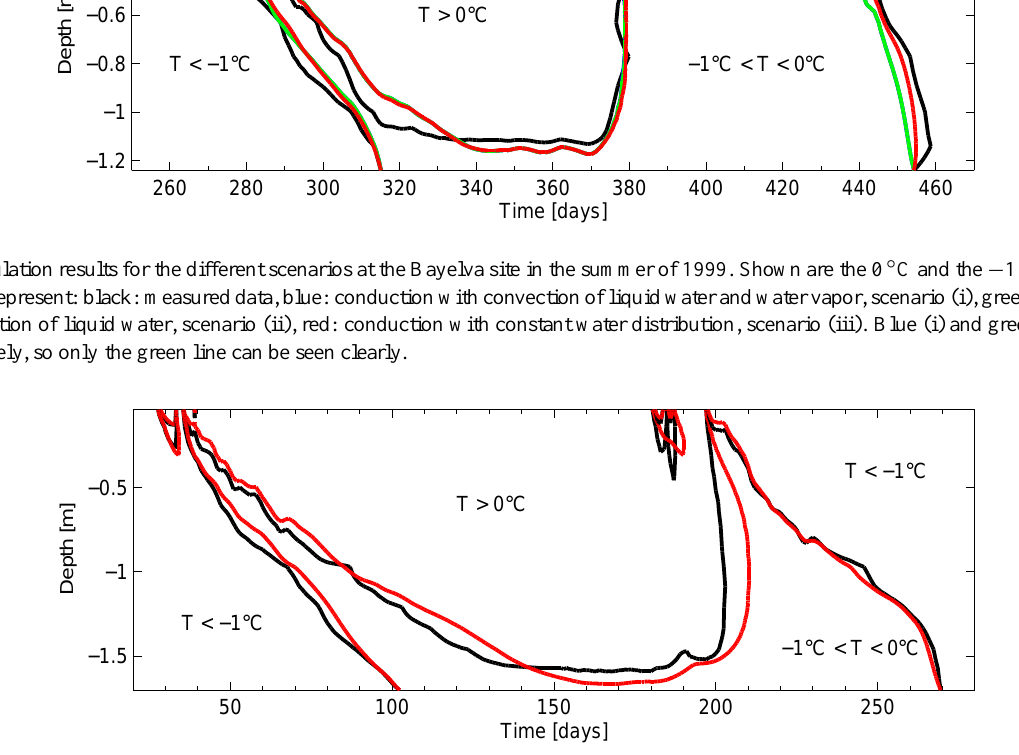
Fig. 9. Simulation results for the different scenarios at the Bayelva site in the summer of 1999. Shown are the 0 ◦ C and the − 1 ◦ C isotherms. The colors represent: Black: Measured data, blue: Con- duction with convection of liquid water and water vapor, scenario (i), green: Conduction with convection of liquid water, scenario (ii), red: Conduction with constant water distribution, scenario (iii). Blue (i) and green (ii) overlap almost entirely, so only the green line can be seen clearly.